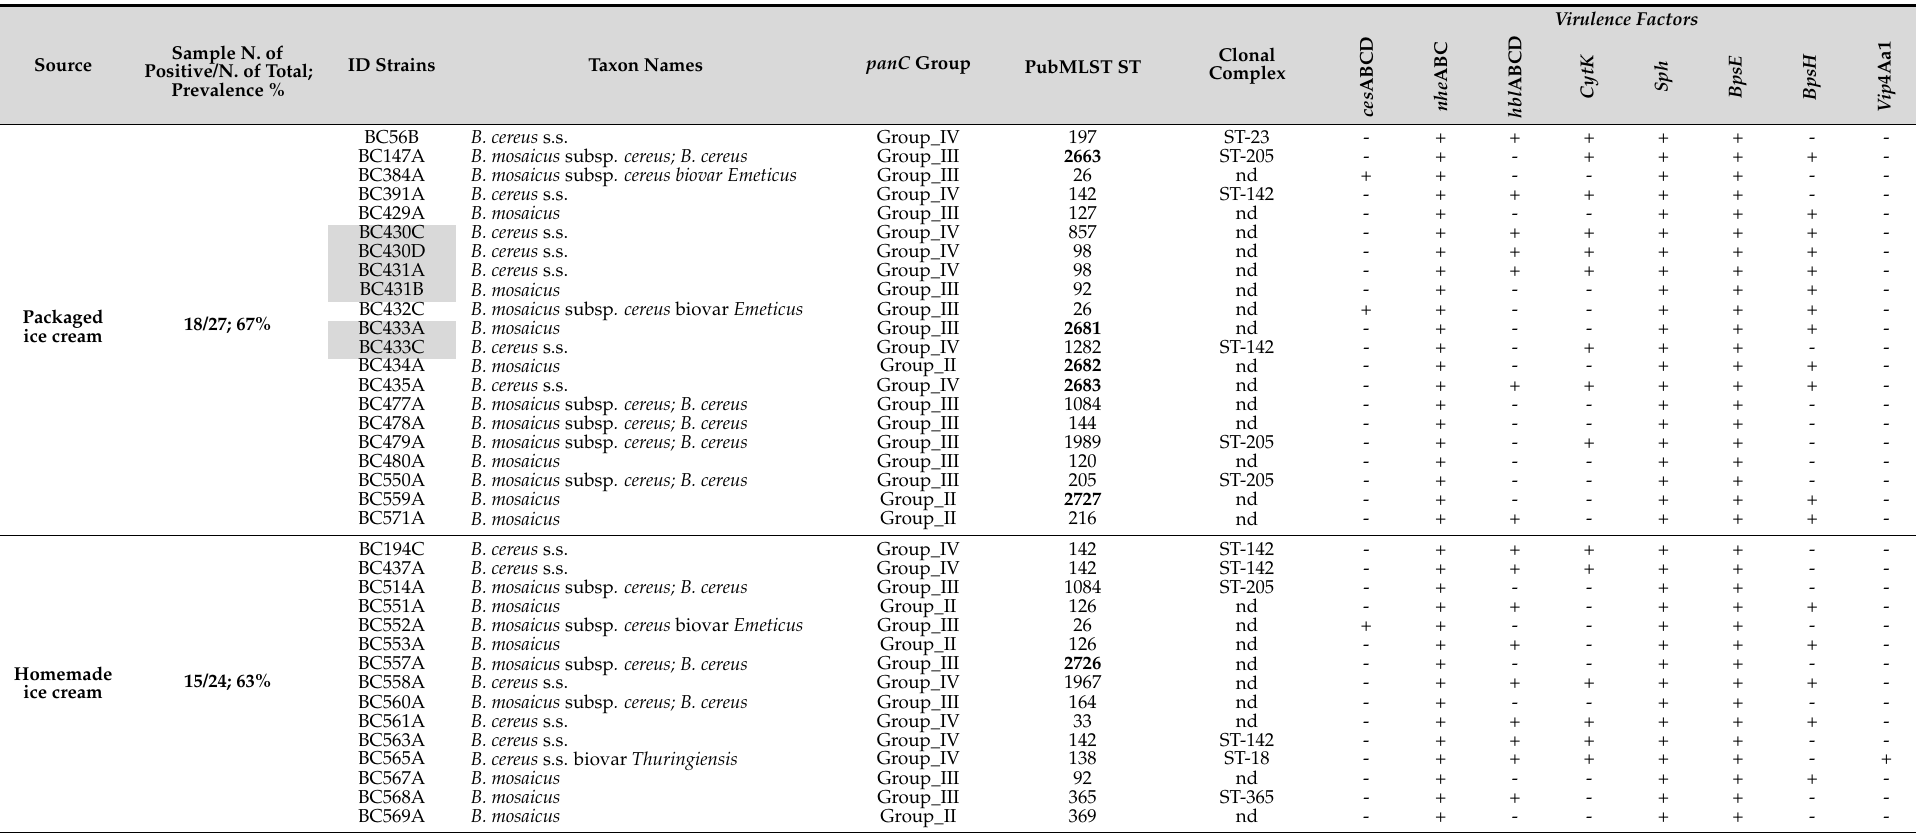
Table 1. Phylogenetic characterization of the 36 isolates of B. cereus s.l. The table shows the data relating to the species identification, phylogenetic cluster, sequence type (ST), clonal complex and major toxin-virulence genes. In grey are indicated the strains isolated from three ice creams that each showed two different B. cereus s.l. profiles. In bold are indicated the new STs identified in the current study. (+): presence; (-):